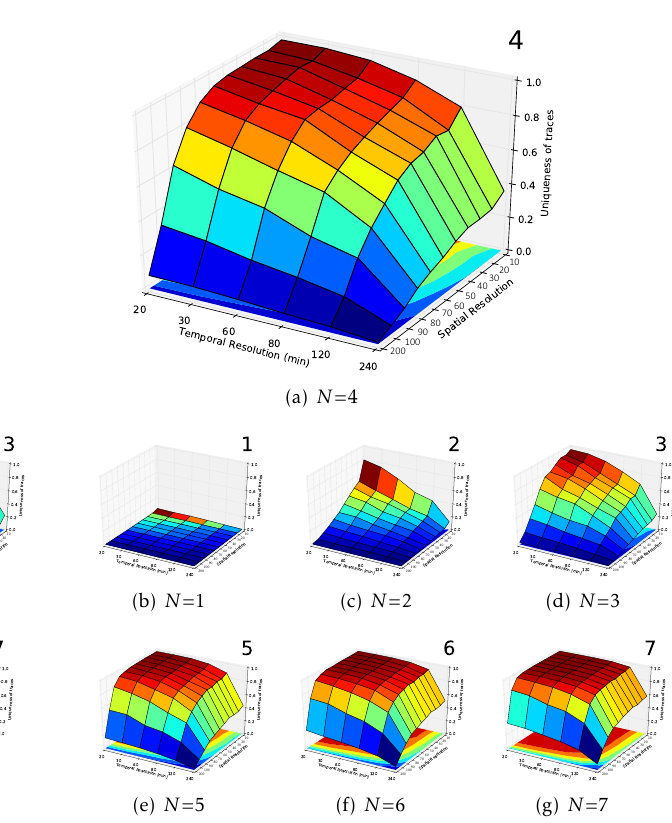
points increases, and its value approximates 100% rapidly when the number is larger than 4. What’s more, the uniqueness of Shanghai’s grows slightly faster than that of Shenzhen’s. By now, we can state that 4 spatio- temporal points are su ffi cient to re-identify a taxi’s